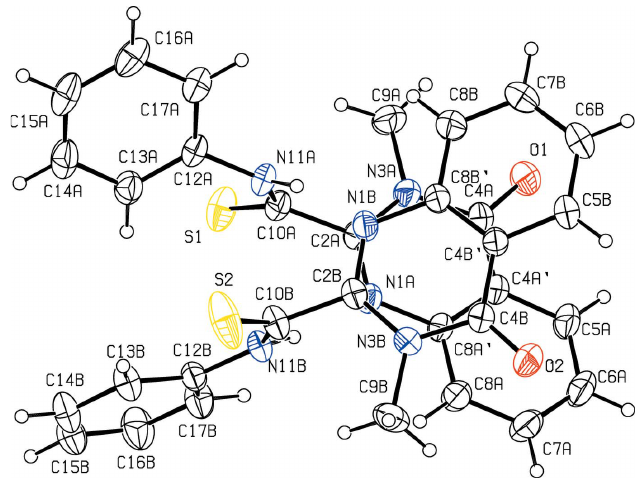
Figure 1 Asymmetric unit of the title compound with the atom-numbering scheme. Displacement ellipsoids for non-hydrogen atoms are drawn at the 30% probability level.